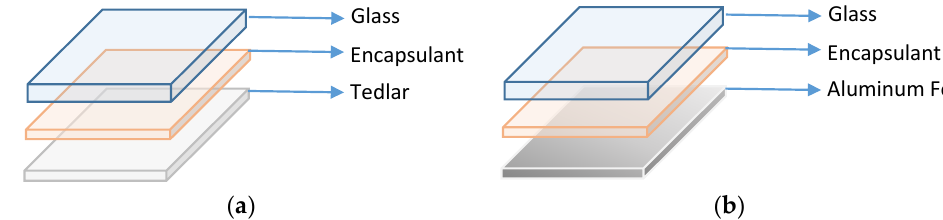
Figure 1. Mini coupon layer orientation with ( a ) Tedlar as back sheet and ( b ) aluminum foil as back sheet.